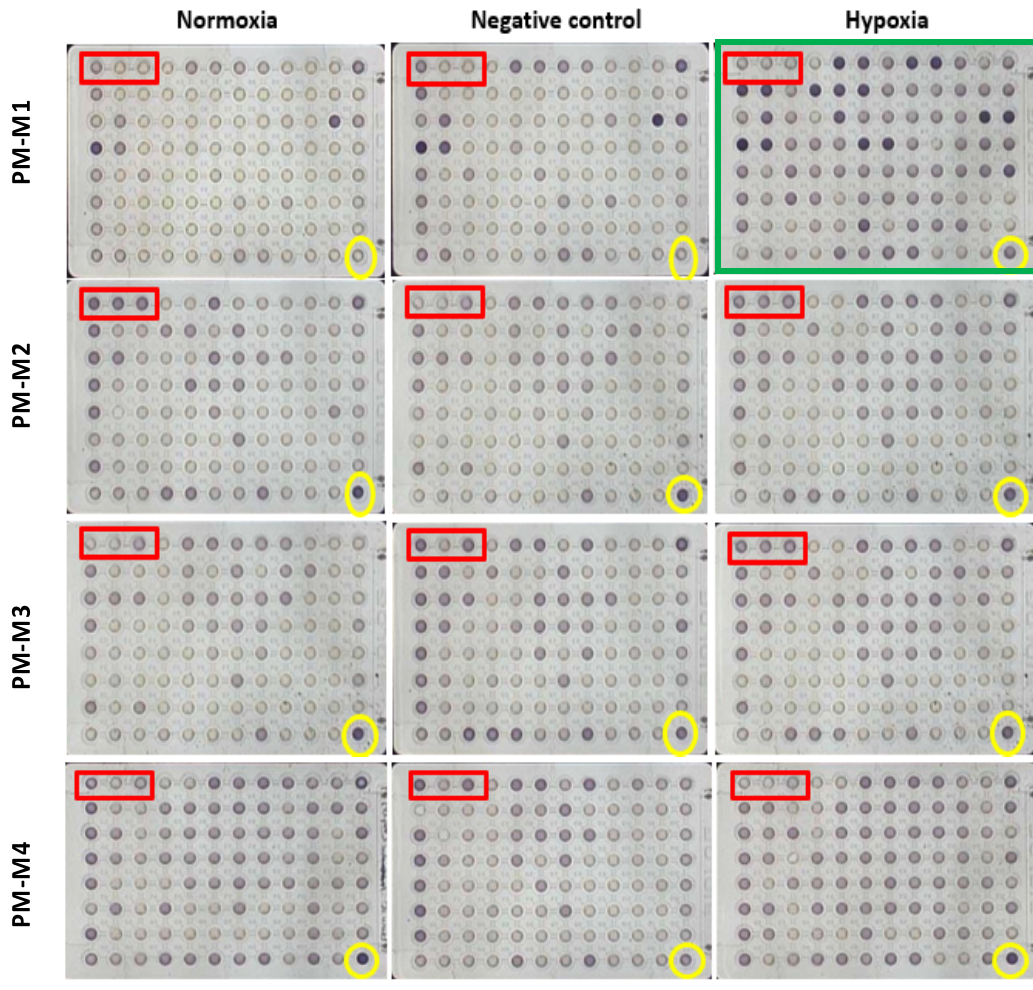
Figure 3. Phenotype ‐ microarray plates containing hypoxia ‐ /non ‐ hypoxia ‐ induced MDA ‐ MB ‐ 231 Figure 3. Phenotype-microarray plates containing hypoxia- / non-hypoxia-induced MDA-MB-231